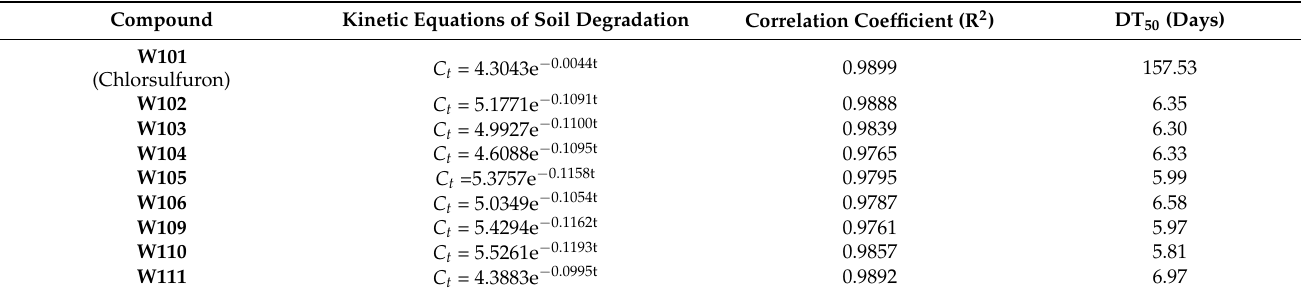
Table 4. Kinetic parameters for alkaline soil (pH 8.39)